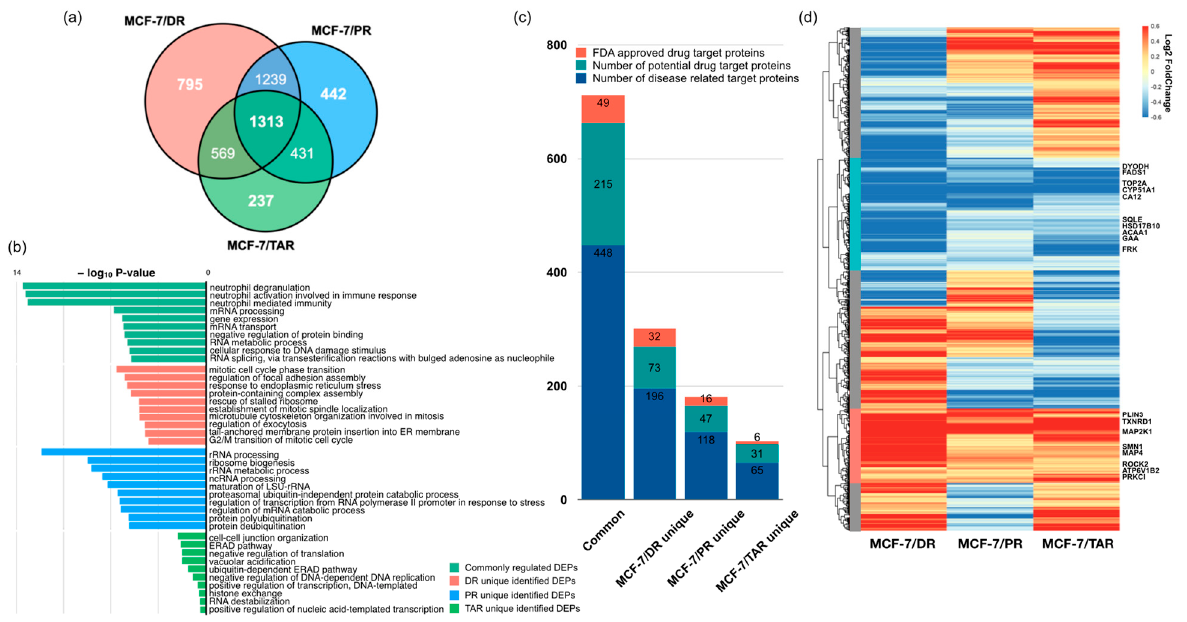
Figure 5. Differentially expressed proteins between the three drug-resistant cell lines. ( a ) Venn diagram showing the overlap of all genes with significantly different expression between parental MCF-7 and drug-resistant cells of Figure 2. ( b ) GO enrichment analysis of DEPs. ( c ) Identification of druggable target proteins on common DEPs and drug-specific DEPs. ( d ) Heatmap using expression levels of the 1313 DEPs commonly significant between parental MCF-7 and each drug-resistant cell line. On the left side of the heatmap, the red bar indicates the 194 upregulated proteins, and the blue bar indicates 295 downregulated proteins. The rest are marked in gray.